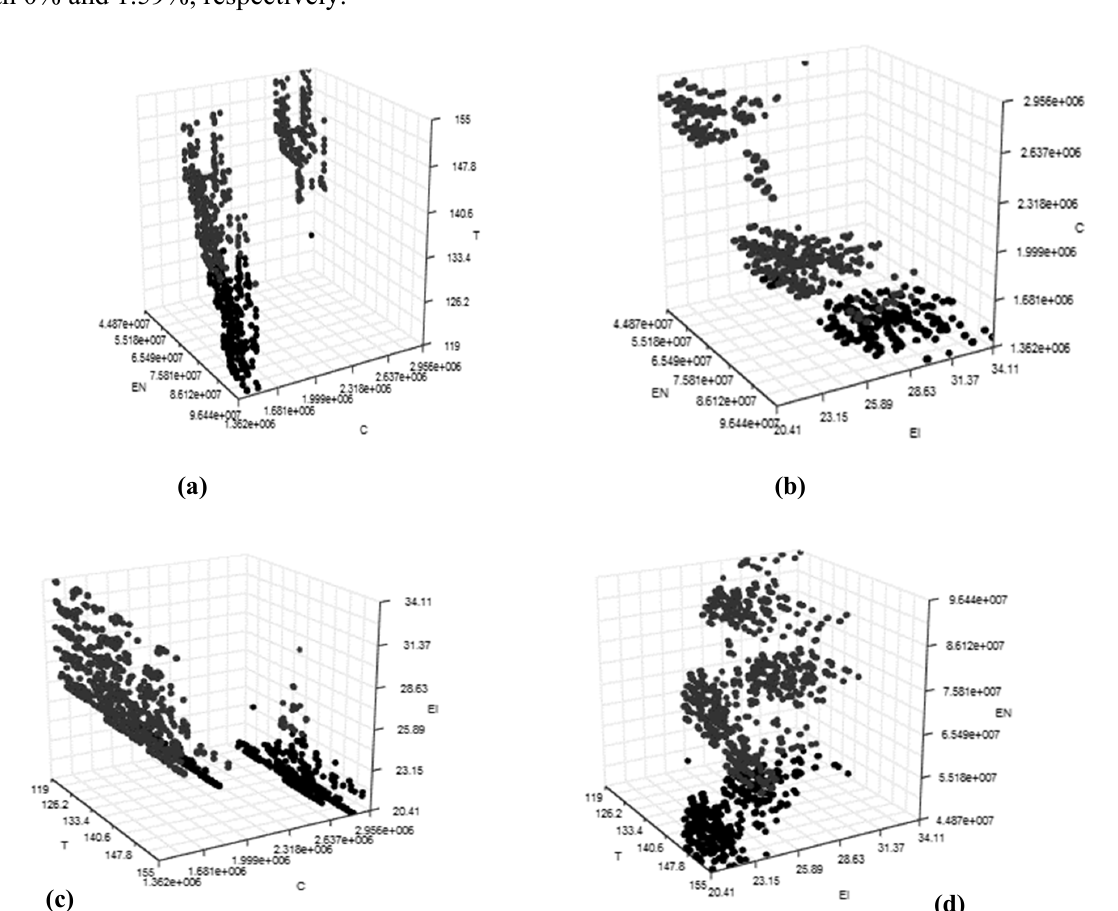
Fig. 11. Generated solutions from optimization